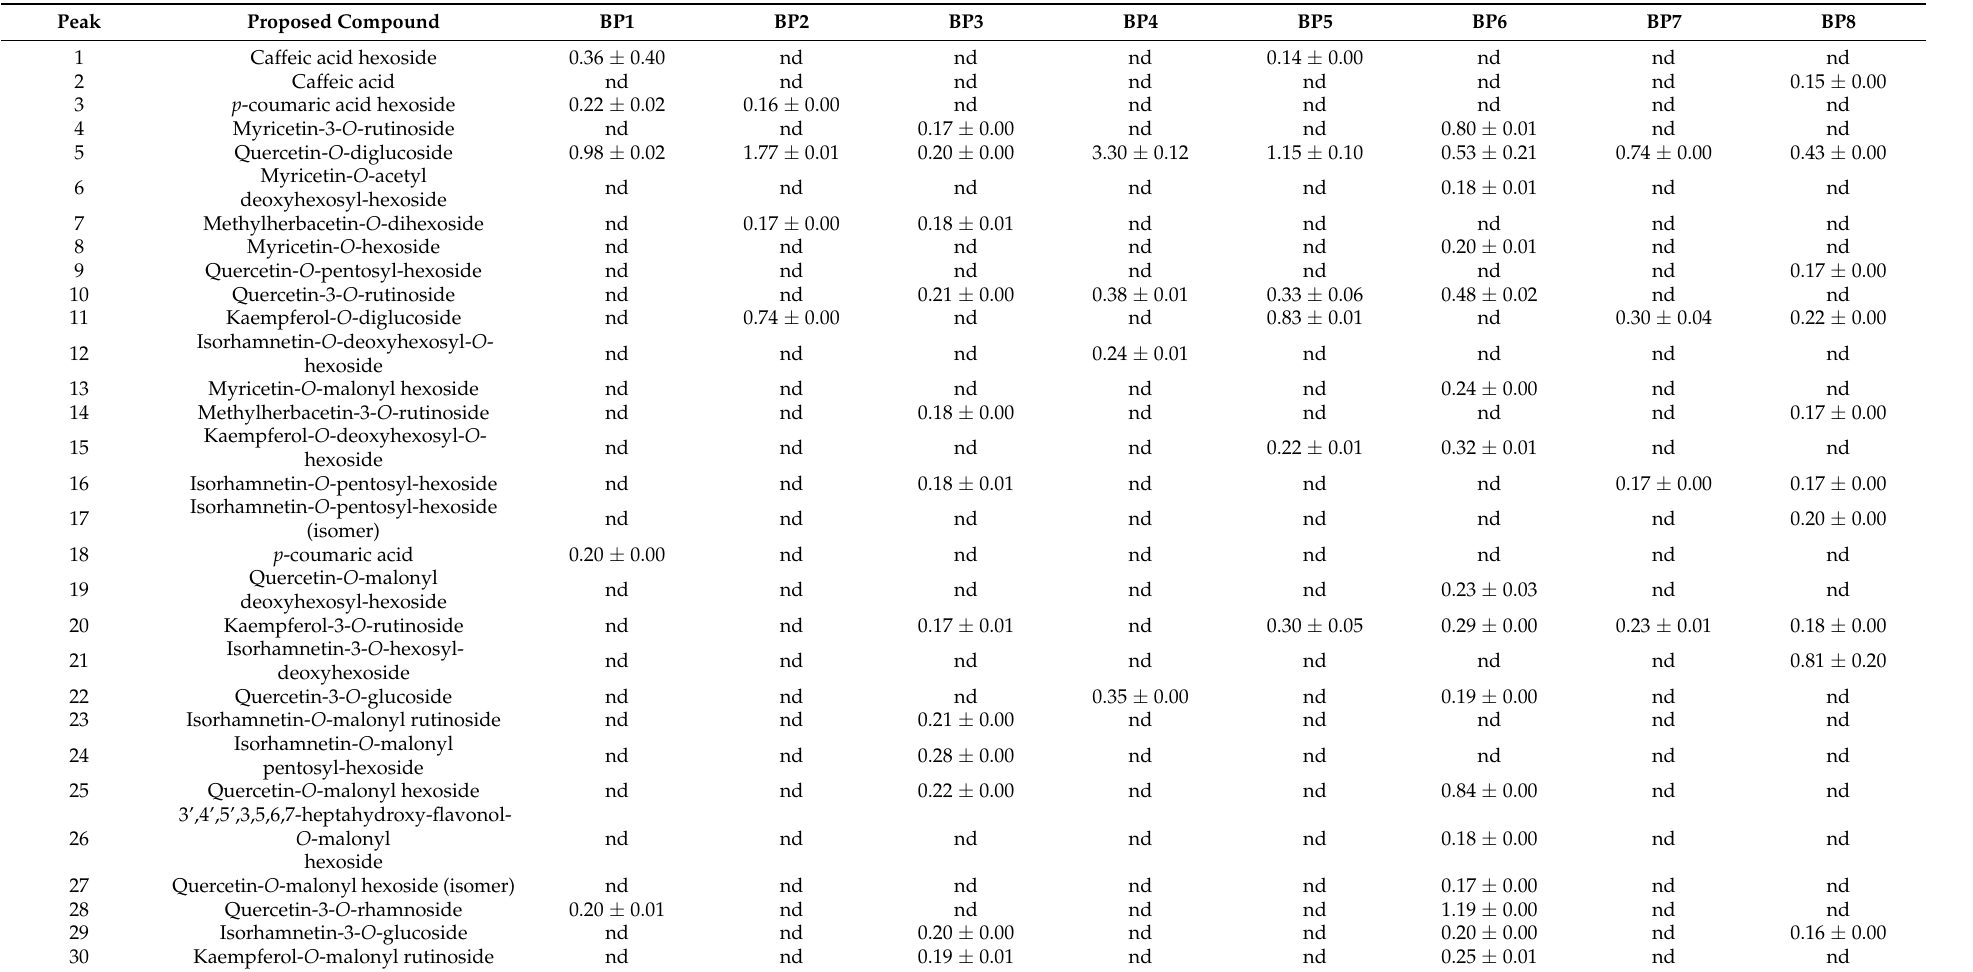
Table 2. Phenolic and phenylamide profile of Moroccan bee pollen samples. The values are expressed as mg of each compound/g of bee pollen.